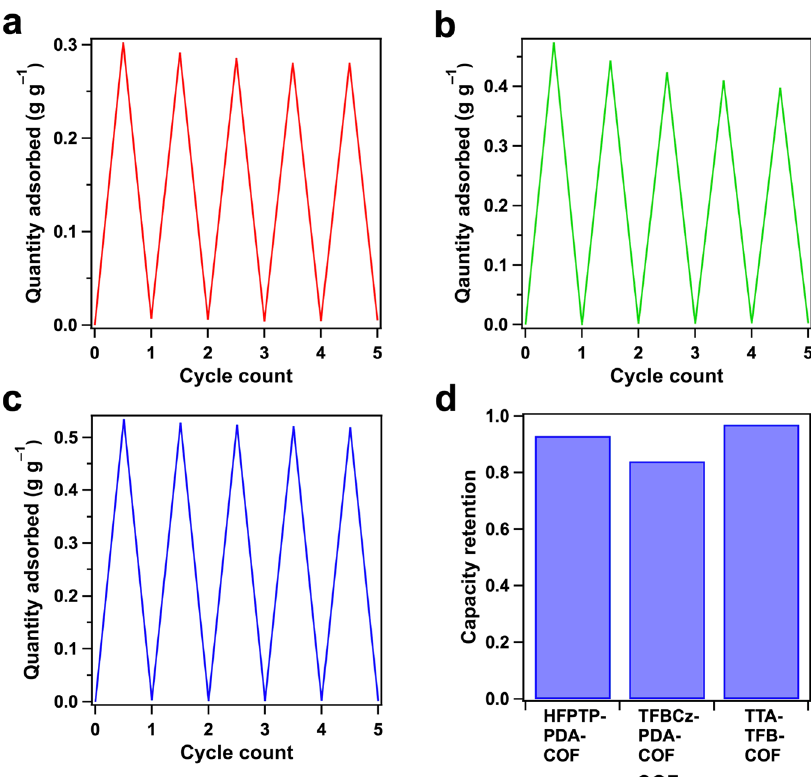
Fig. 5 Cycle performance of water con fi nement. a Cycle performance of HFPTP-PDA-COF. b Cycle performance of TFBCz-PDA-COF. c Cycle performance of TTA-TFB-COF. d Capacity retention of HFPTP-PDA-COF, TFBCz-PDA-COF and